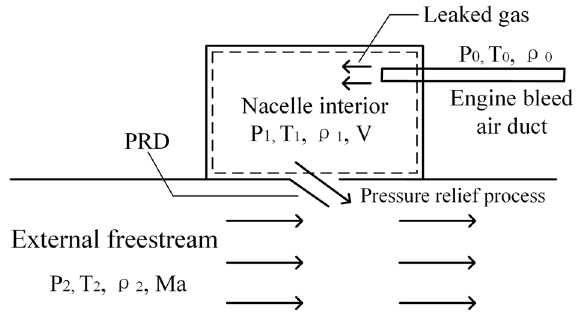
Figure 2. Schematic diagram of the pressure relief